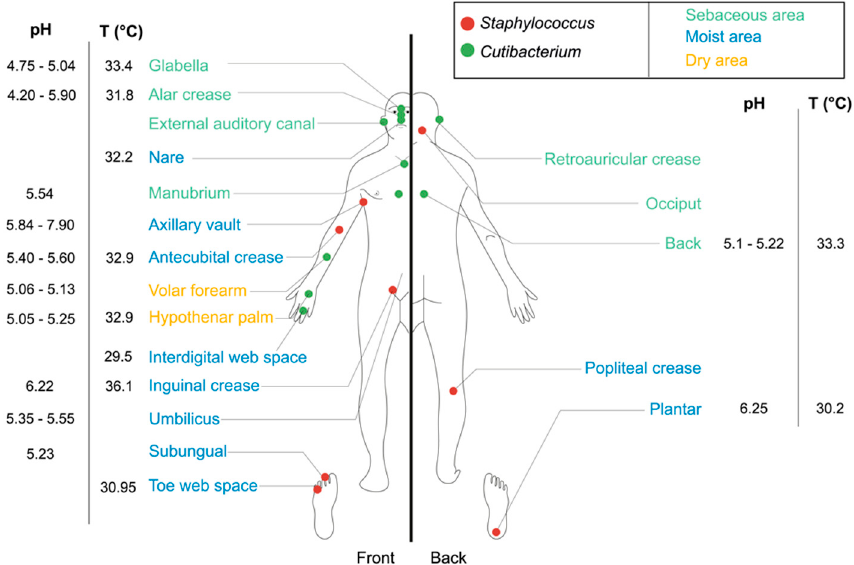
Figure 1. Topographical distribution of Staphylococcus and Cutibacterium bacteria, adapted from Wilson (2005), Grice et al. (2015) and Kong et al. (2012) [6,17,27] .